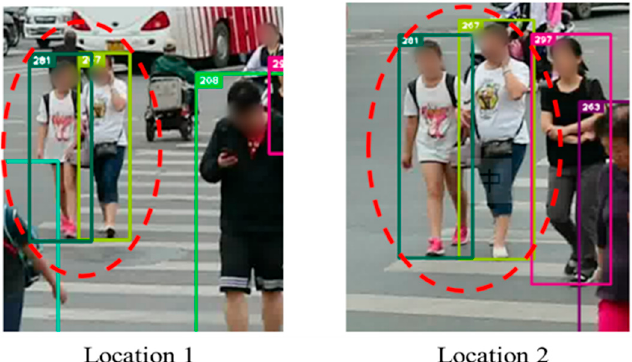
Figure 5. The effectiveness of result on video from intersection. Our method is applied to help identify target persons and track moving trajectories of pedestrians. Table 8. The performance comparison when our model is applied to multiple object tracking.